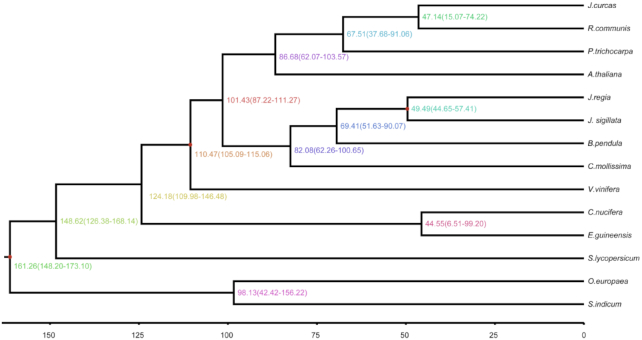
Inferred phylogenetic tree across 14 plant species. The estimated divergence time (Mya) is shown at each node. Numbers in parentheses indicate 95% confidence interval.